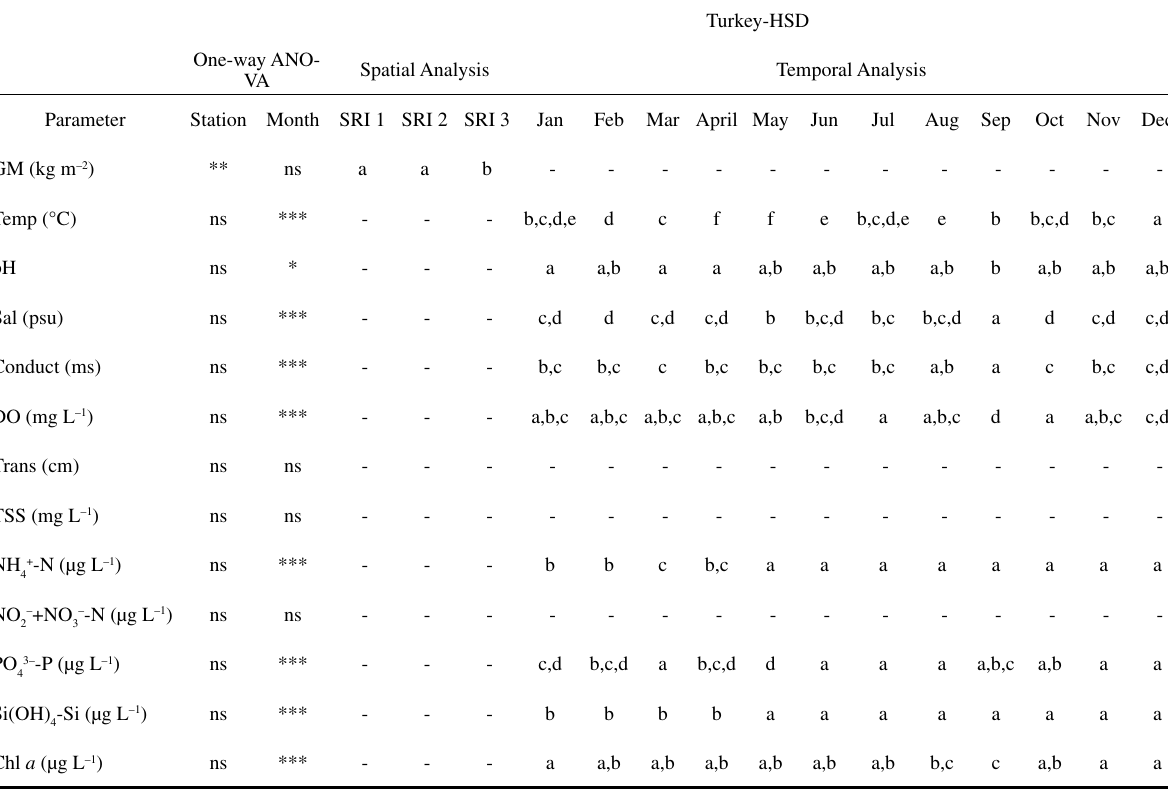
Table S4. – Spatial and temporal variation of green mussel production and seawater parameters in the mussel cultivation areas at Sriracha (SRI) by using one-way ANOVA and